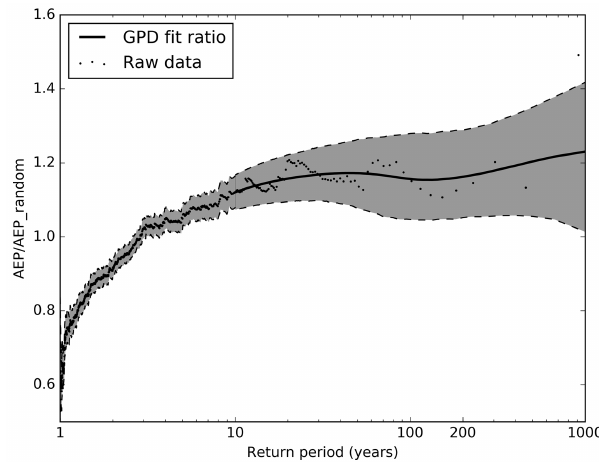
Figure 7. The ratio of the model AEP to the 10000 random samples of the AEP for increasing return period. Black dots are the raw data points. The dark grey region below the 10-year return period indi- cates the 95% confidence interval of the raw AEP/AEP_random. Above the 10-year return period the dark grey shaded region bounded by the black dashed lines is the 95% confidence interval using the fitted AEP (red line in Fig. 6) in the calculation and the black solid line is the median of the spread. Confidence intervals from the GPD fits are only shown above the GPD